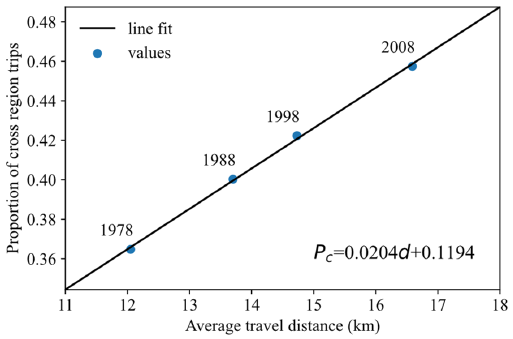
Figure 17. Average travel distance vs. proportion of cross ‐ region trips.